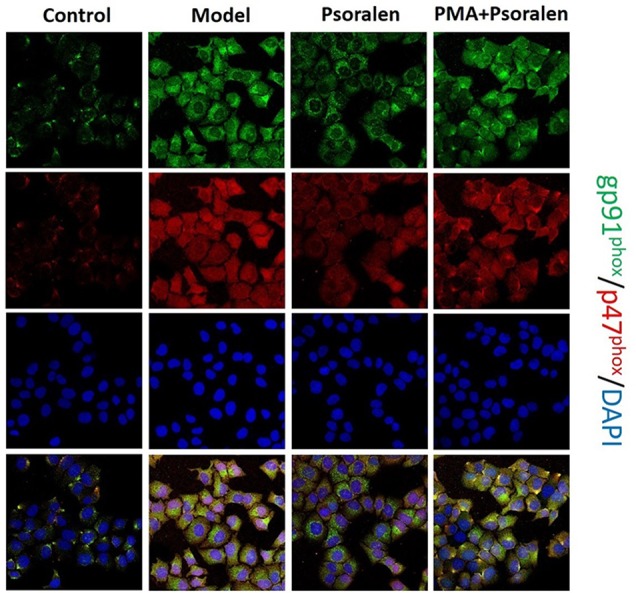
Immunofluorescence of gp91phox and p47phox (×400). gp91phox, green; p47phox, red; DAPI, blue; co-localization of gp91phox/p47phox, yellow. Control: Control group; Model: Model group (0.02 mmol/L PA); Psoralen: Psoralen group (0.02 mmol/L PA + 0.2 μg/ml Psoralen); PMA + Psoralen: Psoralen/activator group (0.02 mmol/L PA + 100 nmol/L PMA + 0.2 μg/ml Psoralen).